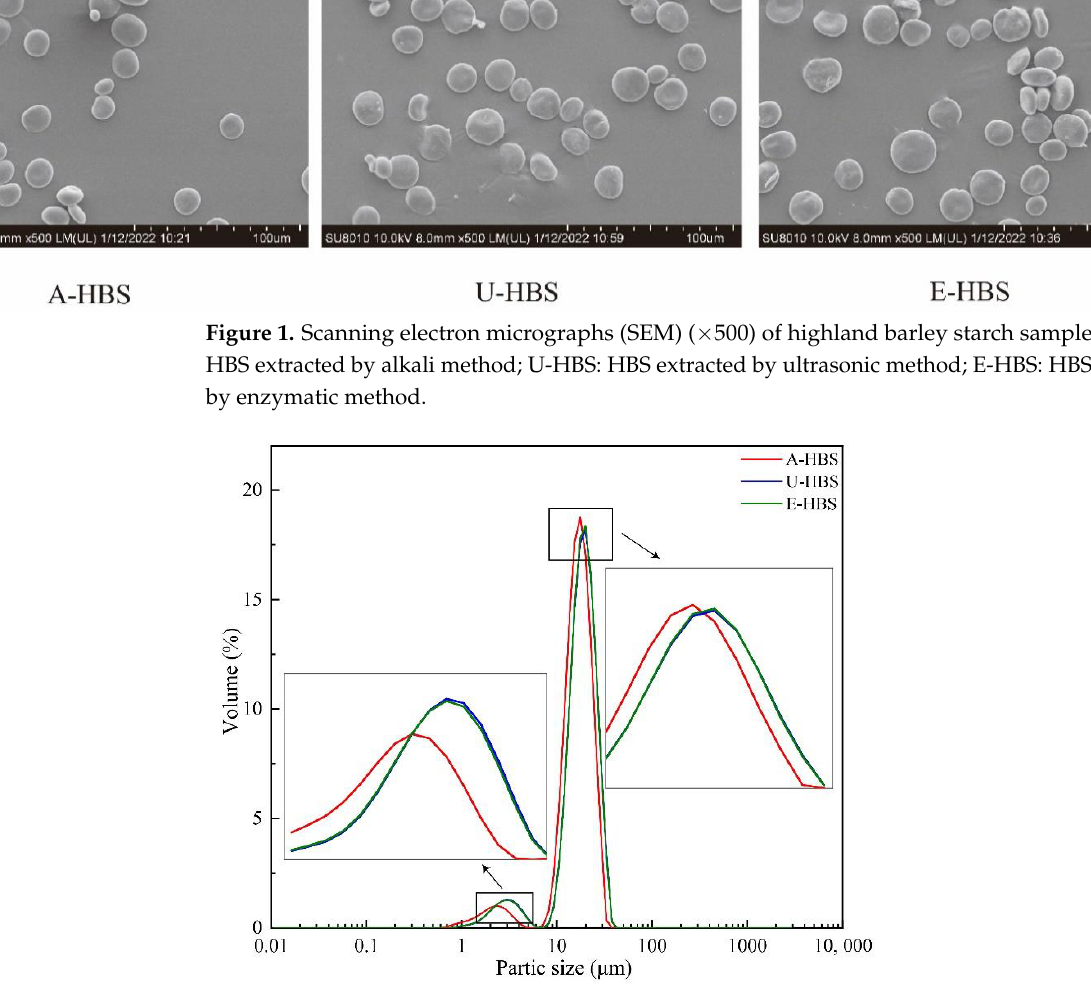
Figure 2. Particle size distribution of highland barley starch samples. A-HBS: HBS extracted by alkali method; U-HBS: HBS extracted by ultrasonic method; E-HBS: HBS extracted by enzymatic method. Table 1. Chemical composition of highland barley starch samples.